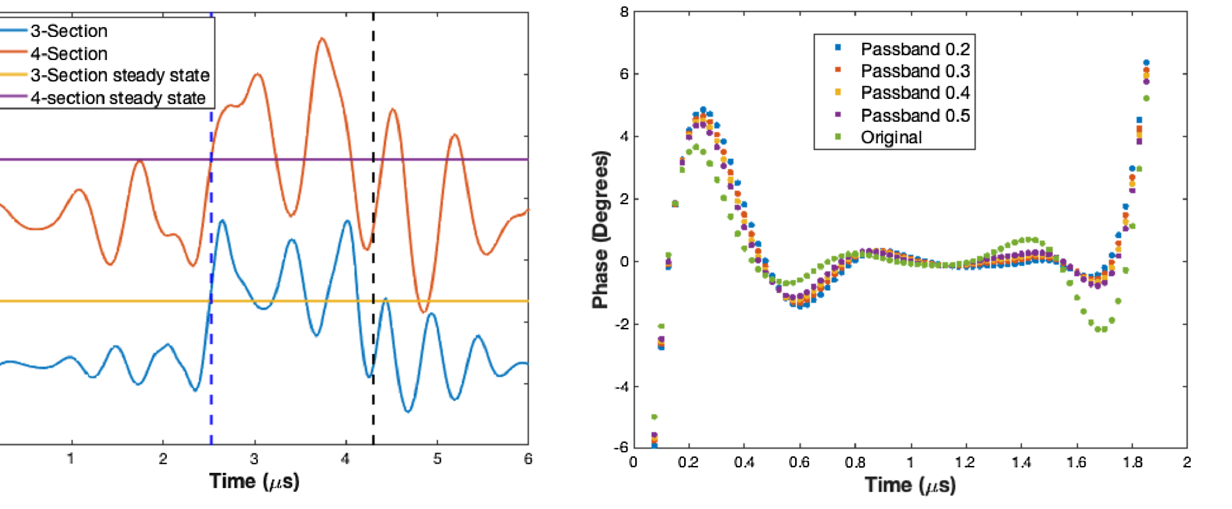
cavity.FIG. 20. Beam phase with original and new